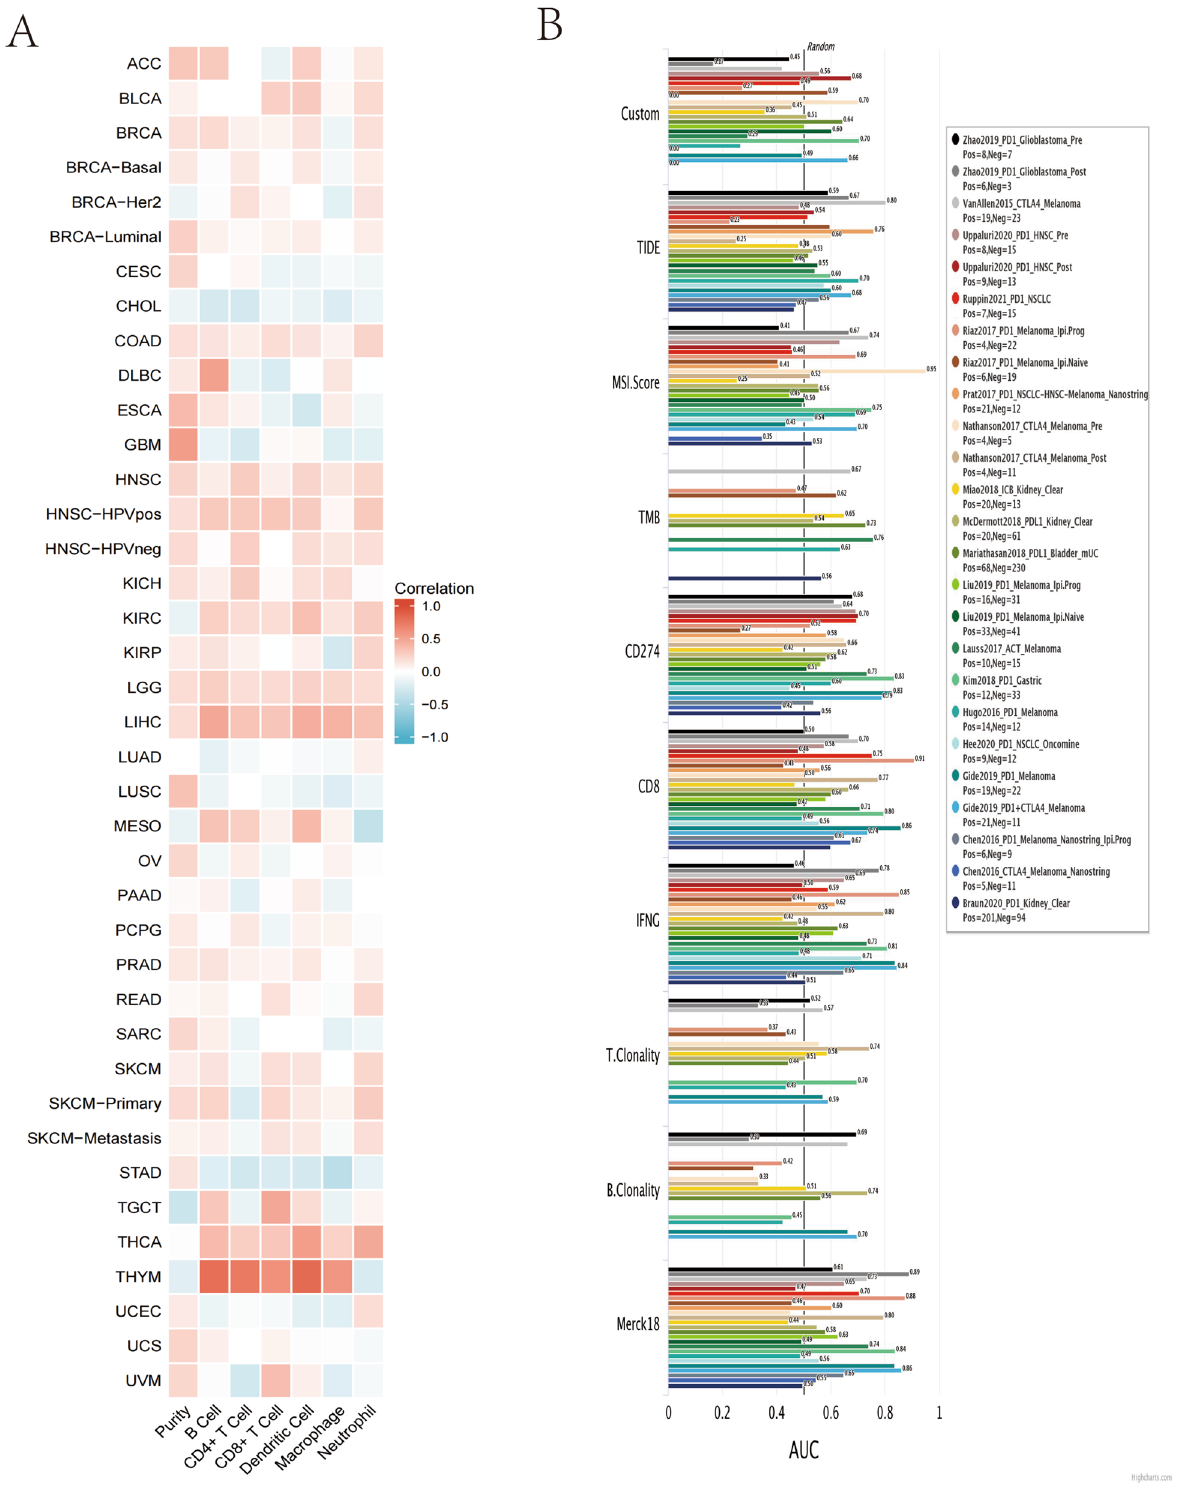
Figure 5. In TCGA cancer types and subtypes of 39 assessing tumor immune infiltration ( A ). The biomarker correlation of HJURP ( B